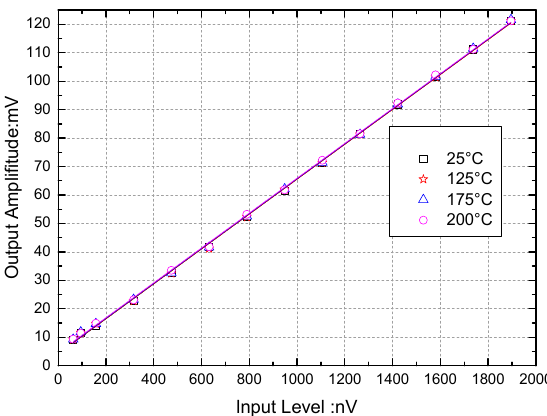
Figure 13. Outputs of the digital lock-in amplifier (DLIA) change along with the sine wave input from a variable amplifier. The DLIA input frequency was 800 kHz, and the equivalent amplitude range of the sine wave signal was 94.8–1896.0 nV. The theoretical gain of the DLIA was about 96.211 dB.